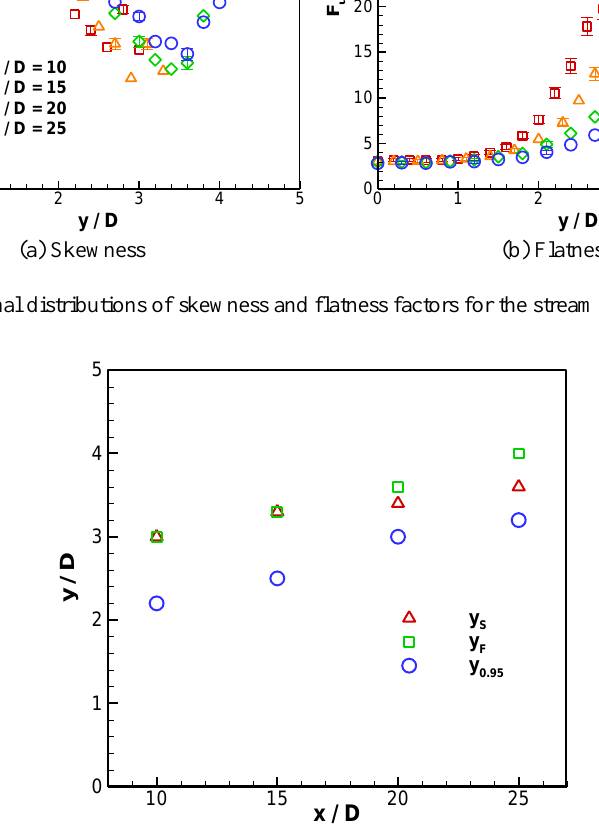
Fig. 6 Stream-wise evolution of peak positions of skewness and flatness factors as well as that of y